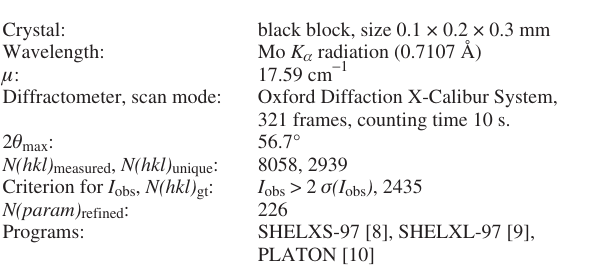
Table 1. Data collection and handling.